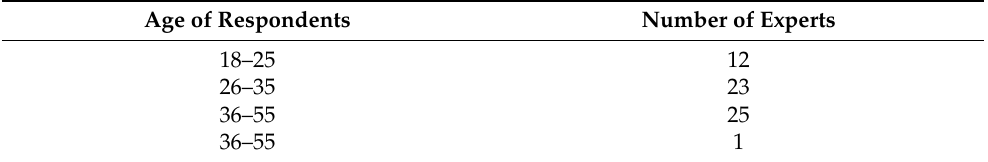
Table 1. Age of the respondents.